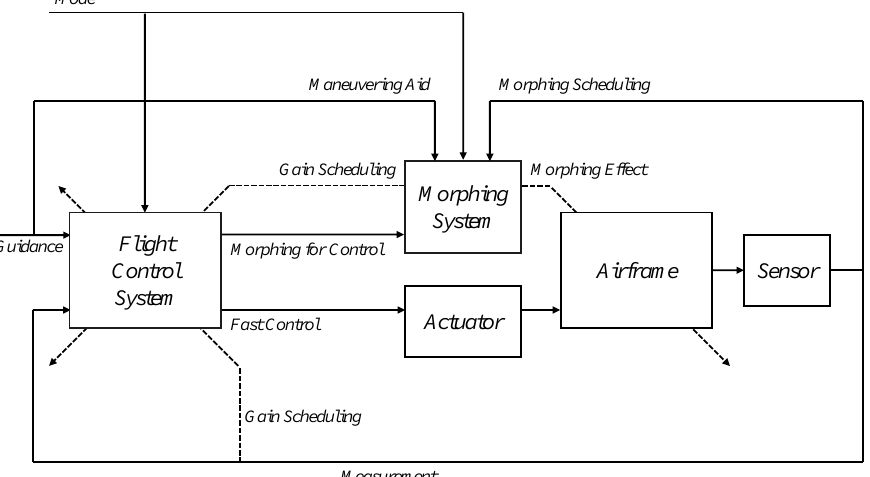
Figure 7. Control system design framework for morphing